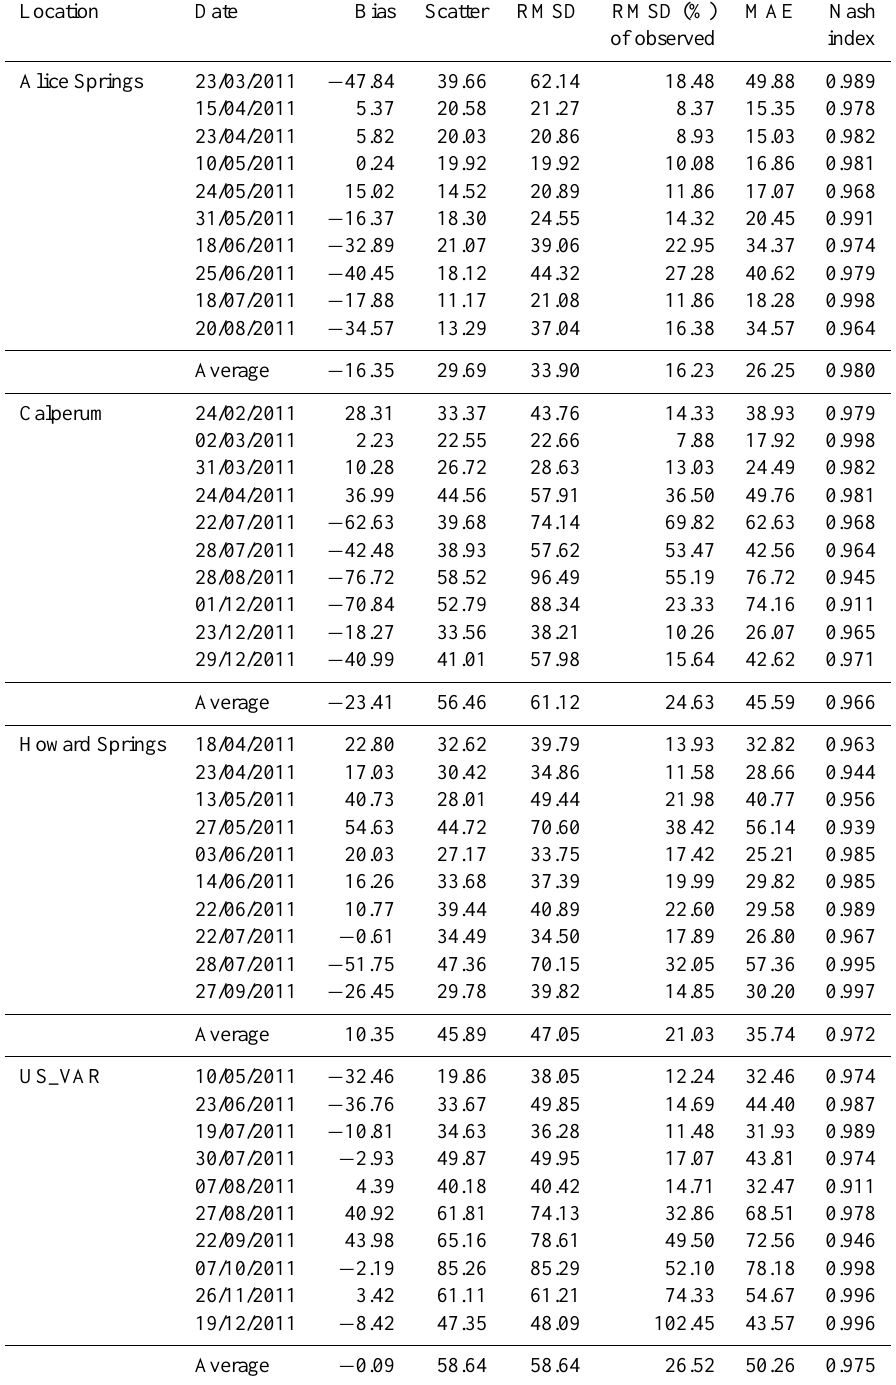
Table 4. Daily simulation accuracy and average site simulation accuracy for R net fluxes. Bias, scatter, RMSD and MAE are expressed in Wm − 2 . Nash index is